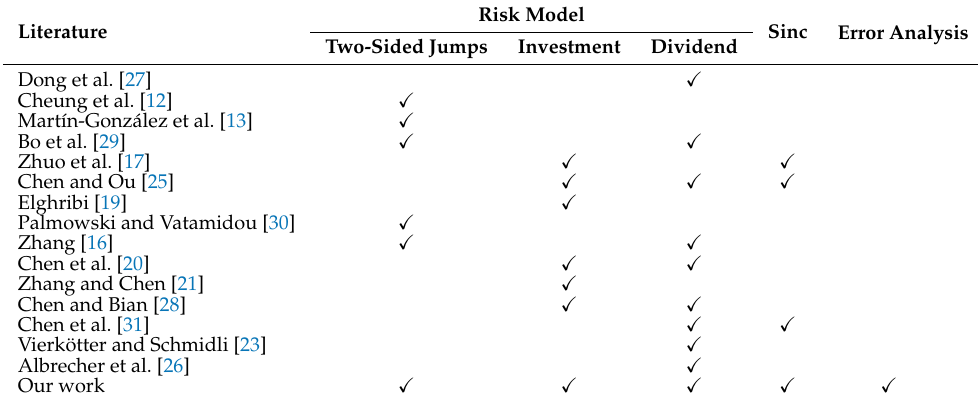
Table 1. The comparison of the relevant